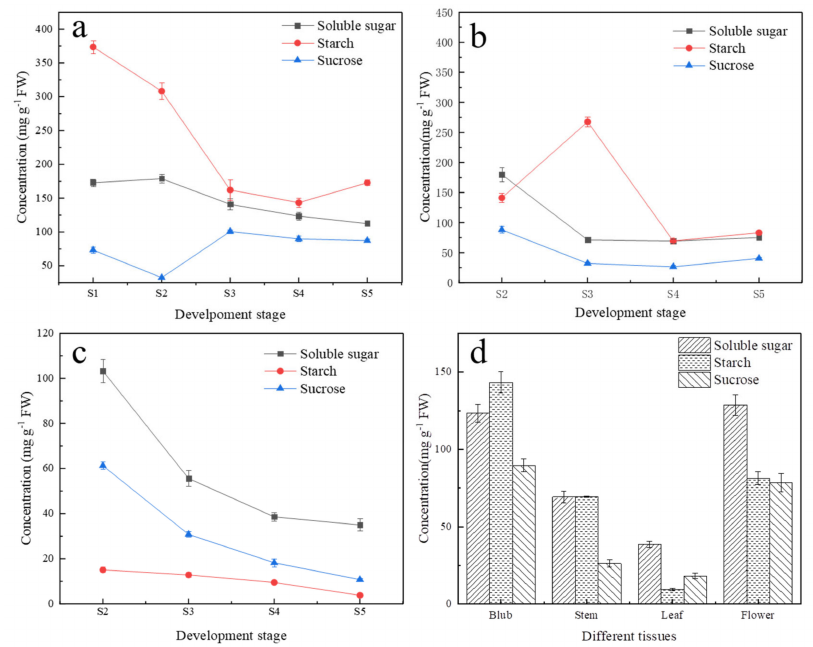
Figure 1. Soluble sugar, starch and sucrose contents (mg/g) in different tissues at different develop- ment stages in lilies. Each value indicates Mean ± SE (standard error). ( a ) Carbohydrate contents in bulbs. ( b ) Carbohydrate contents in stems. ( c ) Carbohydrate contents in leaves. ( d ) Carbohydrate contents in different tissues at S4